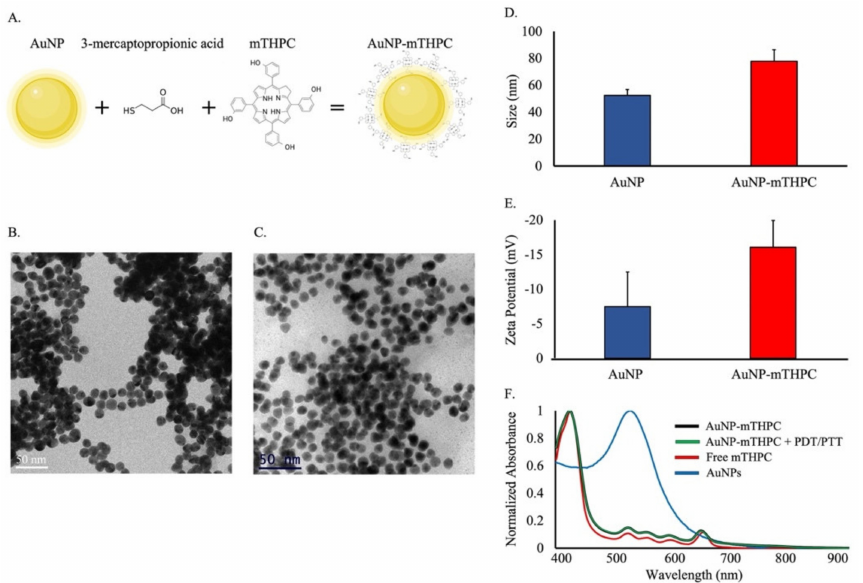
Figure 1. Size characterization and spectroscopic measurements of AuNP and AuNP–mTHPC. ( A ) AuNP–mTHPC complex illustration: a chemical structure of mTHPC in the conjugates and the linker 3-mercaptopropionc acid. ( B ) Left image depicts bare AuNPs, and ( C ) right image depicts AuNP–mTHPC. ( D ) Dynamic light scattering (DLS) measurement of the AuNP and AuNP–mTHPC. ( E ) Zeta potential measurements of AuNP and conjugated with mTHPC. ( F ) Normalized absorbance spectra of free AuNP (blue), AuNP–mTHPC (black), free mTHPC (red), and AuNP–mTHPC irradiated under 650-nm laser (PDT) at 6 mW/cm 2 for 4 min and illuminated under 532-nm laser (PTT) at 15 mW/cm 2 for 4